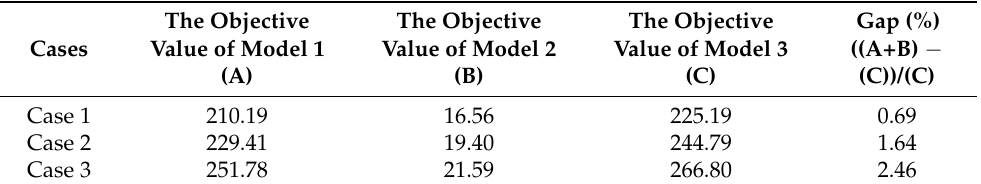
Table 3. The experimental results for the change in the number of yard blocks and time windows.